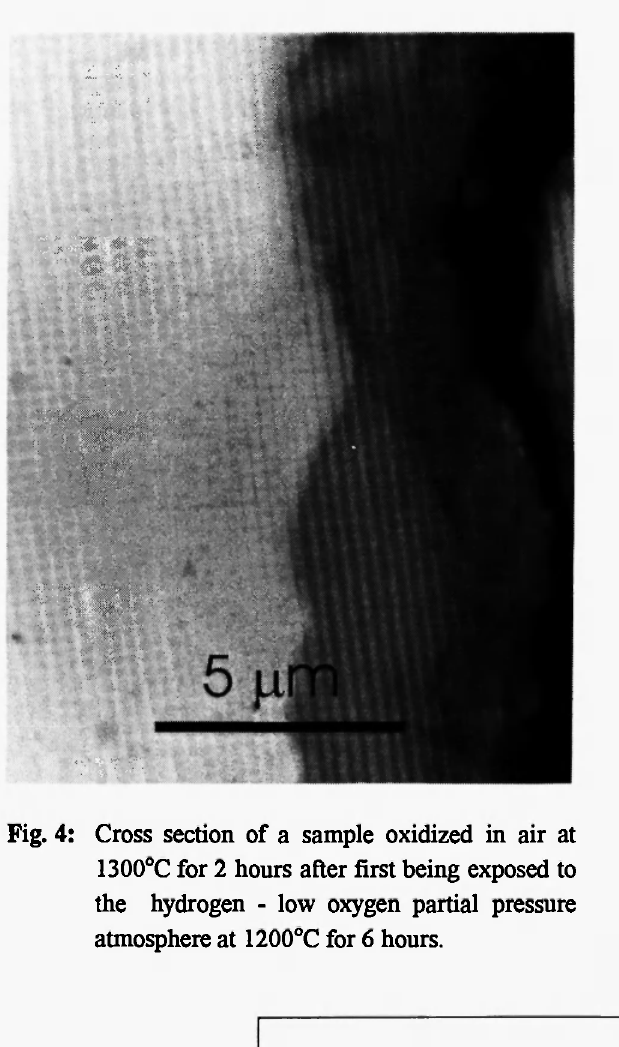
Fig. 4: Cross section of a sample oxidized in air at 1300°C for 2 hours after first being exposed to the hydrogen - low oxygen partial pressure atmosphere at 1200°C for 6 hours.